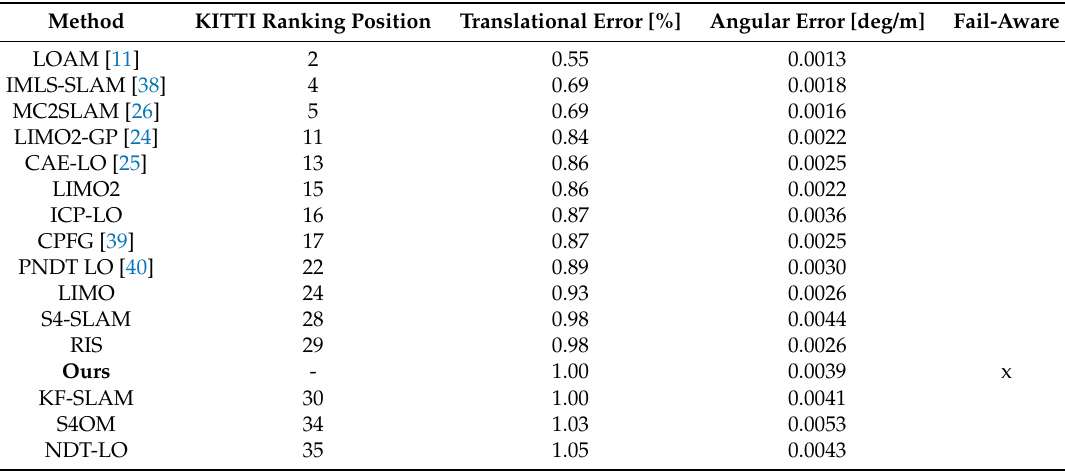
Table 4. Comparison of LIDAR-based methods ranked on KITTI data